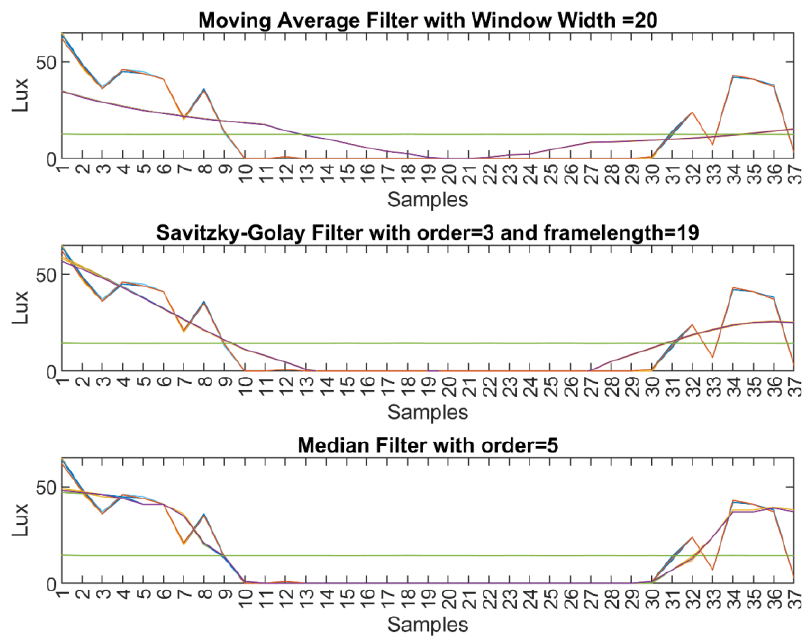
Figure 10 . All 37 light sensors data filtering results for different methods. Figure 10. All 37 light sensors data filtering results for different